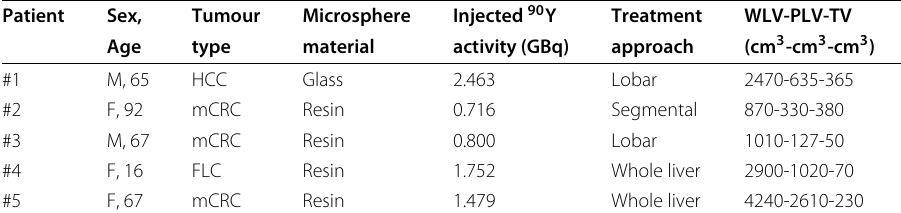
Table 2 Patient